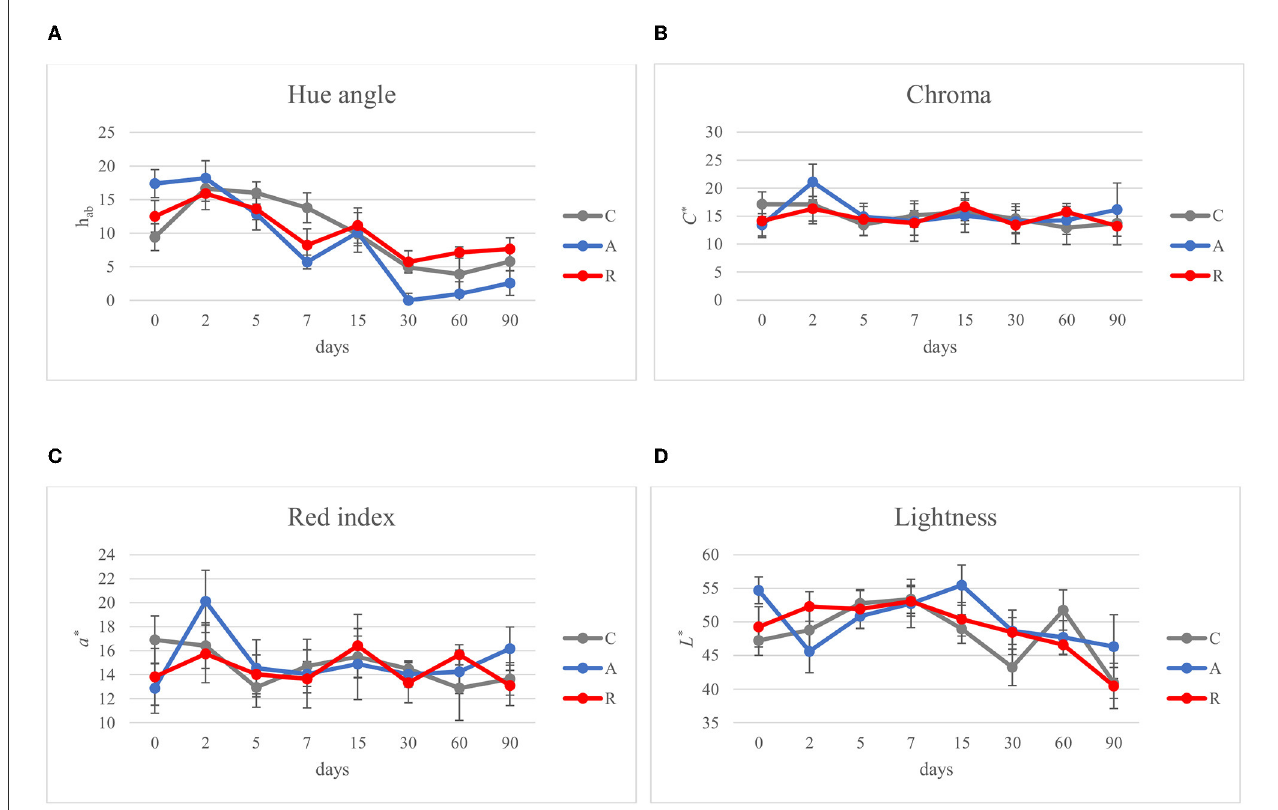
FIGURE5 Evolution of color parameters during ripening of: non-inoculated sausages, C; sausages inoculated with Lcb. casei N87 cultivated under anaerobiosis A; sausages inoculated with Lcb. casei N87 cultivated under respiratory conditions R. (A) Hue angle, h ab ; (B) Chroma, C * ; (C) Red/green value, a * ; (D) Lightness, L *. Error bars refer to the standard deviations obtained from triplicate sample